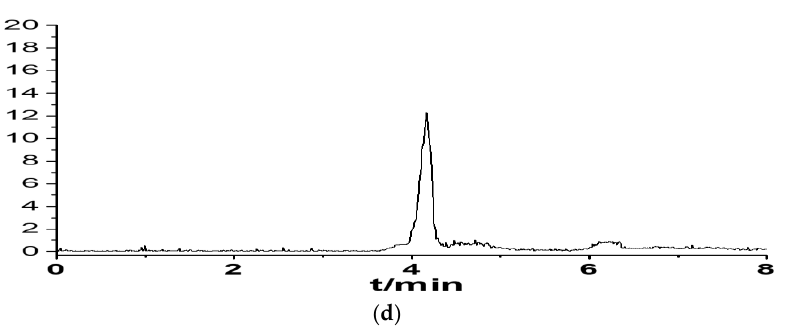
Figure 3. Typical chromatograms of ( a ) blank serum, ( b ) vancomycin standard in deionized water (500 ng/mL), ( c ) vancomycin standard in serum (patients after treated with vancomycin), ( d ) blank sample spiked with vancomycin (1 ng/mL).